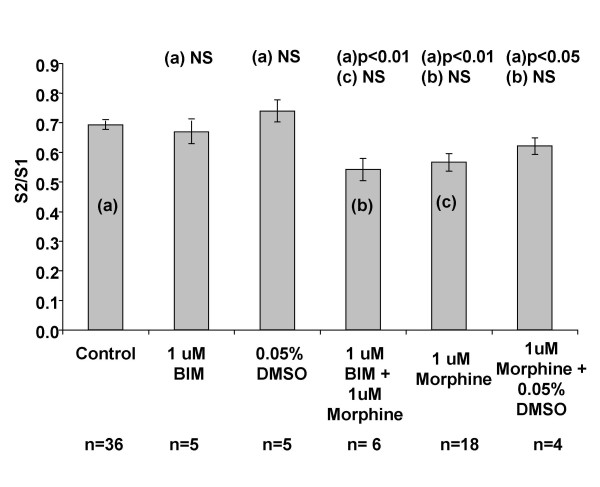
Effect of protein kinase C inhibitor bisindolylmaleimide I (BIM) on morphine modulation of [3H]GABA release. BIM is reported to reduce receptor desensitization and was used here to test whether morphine would elicit a bigger effect on [3H]GABA release in the presence of BIM. BIM is initially dissolved in DMSO whose effect on [3H]GABA release was also tested. BIM (1 μM) was present throughout the perfusion where indicated. Data represent averages ± SEM. Labels on the x-axis indicate concentration of morphine present during S2. The data show that morphine caused a reduction of [3H]GABA release as shown in Figure 2 but there was no statistical difference between experiments with or without BIM (One way ANOVA).